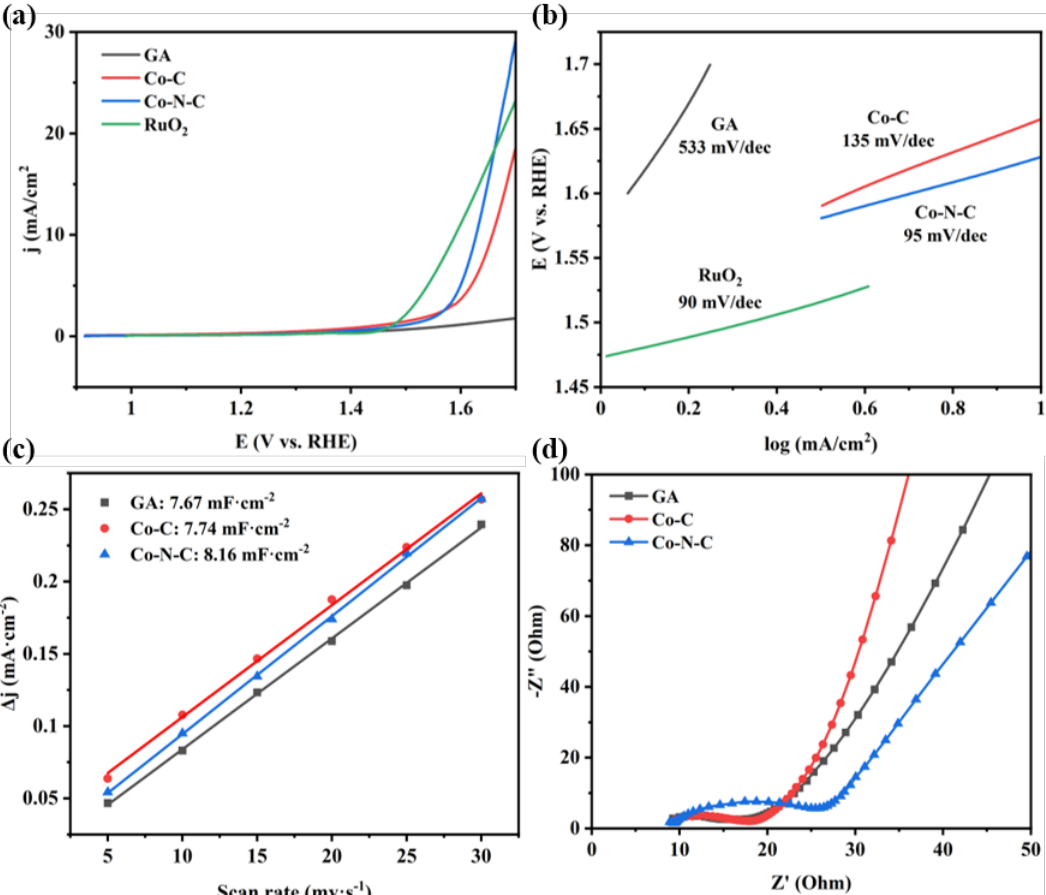
Figure 4. ( a ) LSV, ( b ) the Tafel curves, ( c ) current density differences plotted against the scan rate, and ( d ) EIS for GA, Co-C, and